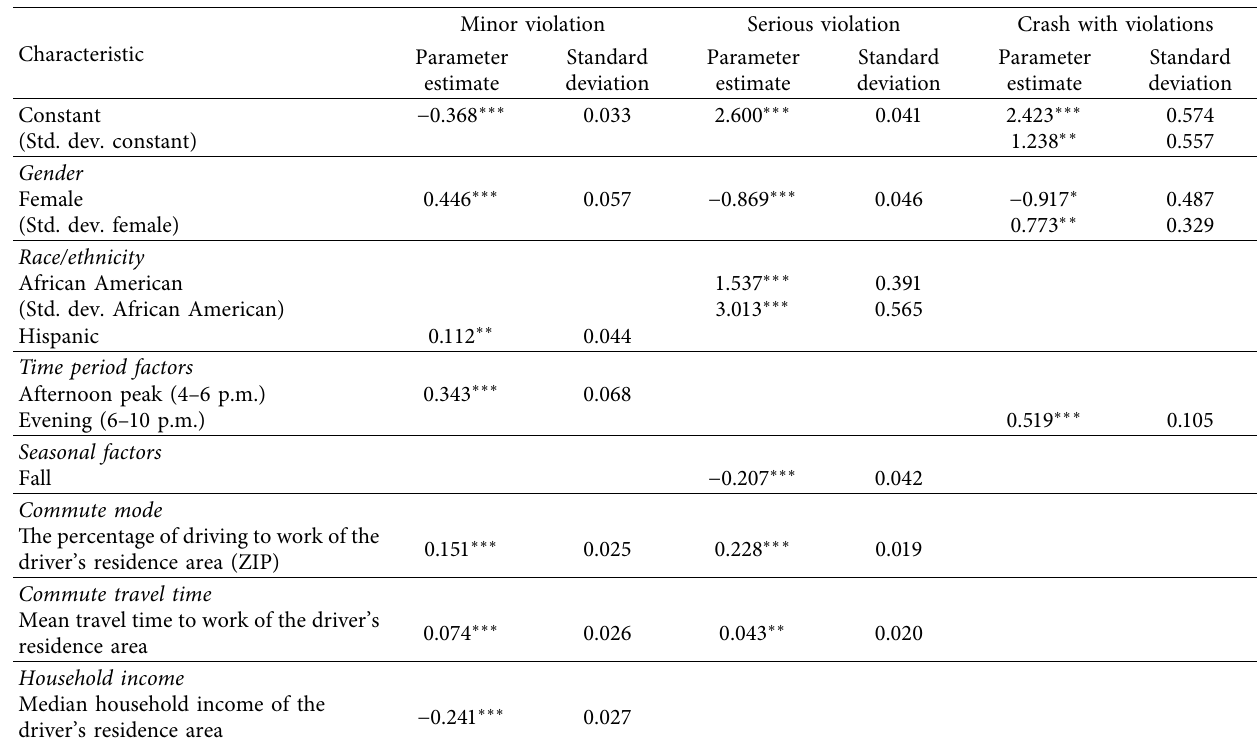
Table 4: Estimation results of the random parameters multinomial logit model for the seriousness of traffic violations.